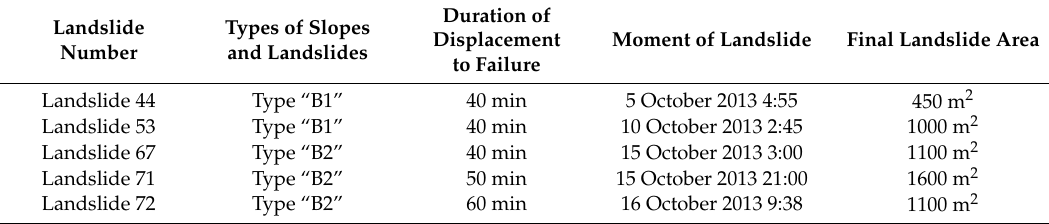
Table 5. Characteristics of the five test landslides.